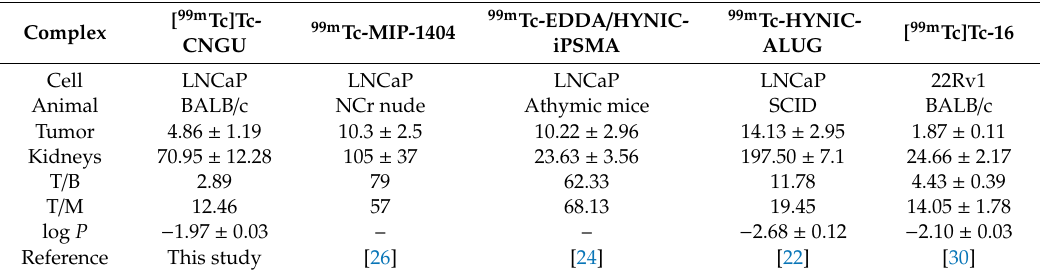
Table 1. Comparison of the biodistribution of [ 99m Tc]Tc-CNGU and other 99m Tc-labeled glutamate- urea-based PSMA-targeted